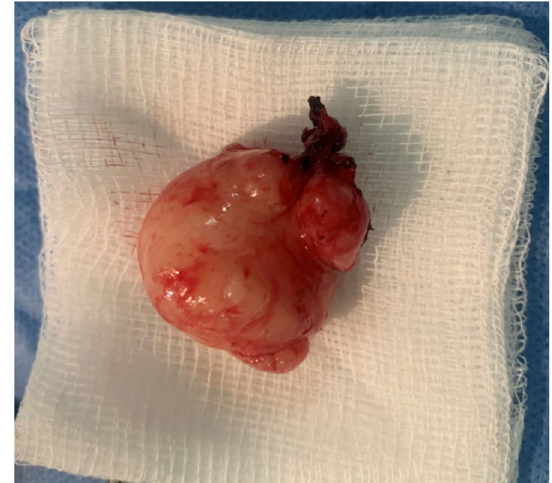
Fig. 5 The surgical specimen presented as submucosal well-encapsulated firm white